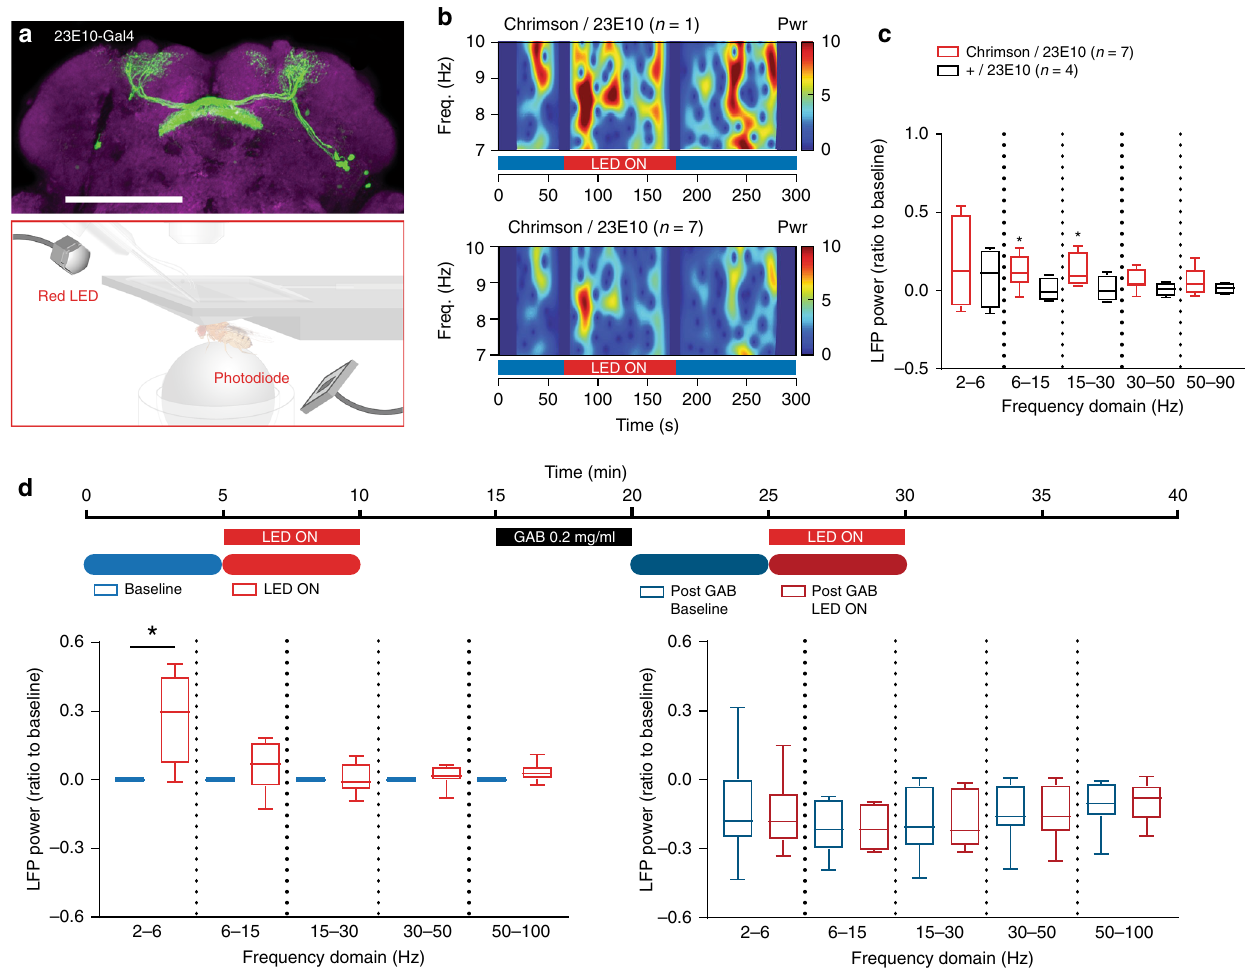
Fig. 5 Low-frequency oscillations generated from activating the dorsal fan-shaped body (dFB) are abolished by Gaboxadol. a Target neurons for optogenetic activation (top), using the dFB-speci fi c driver 23E10-Gal4 as visualized by green fl uorescent protein (GFP) expression (green). Scale bar = 100 μ m. In vivo exposed-brain LFP recording setup as in Fig. 3a, optimized for optogenetic experiments (bottom, see Methods section). b Spectrogram of a fl y expressing 23E10-Gal4/UAS-CsChrimson (Chrimson/23E10) showing the presence of 7 – 10 Hz oscillation when dFB was optogenetically activated (top) and the averaged spectrogram ( n = 7, bottom). Blue vertical bars represent excluded data due to the presence of external artifact. Bottom bar indicates when the light stimulus was on for all experiments (LED ON, red). c Photostimulation of CsChrimson-expressing dFB neurons was associated with a signi fi cant increase in the averaged 6 – 15 Hz and 15 – 30 Hz LFP power in the dFB (orange, n = 7, * p < 0.05 by Wilcoxon signed rank test comparing to baseline of zero), while this effect was not observed in the control strain 23E10-Gal4/+ (+/23E10, black, n = 4, ns by Wilcoxon signed rank test comparing to baseline of zero). d Top: experimental timeline indicating the time point of delivery of optogenetic stimulation, once prior to the delivery of Gaboxadol (0.2 mg/ml), and repeated once thereafter. Prior to exposure to drug, there was a signi fi cant increase in the average 2 – 6 Hz LFP power when optogenetically stimulated (bottom left, n = 8, * p < 0.05, by Wilcoxon matched pairs signed rank test between pre and post drug). No signi fi cant changes to the average LFP power of any frequency domain were detected with optogenetic stimulation after the drug was delivered (bottom right, n = 8, ns, by Wilcoxon matched pairs signed rank test between pre and post drug). Sample sizes indicate the number of fl ies tested. Images: Melvyn